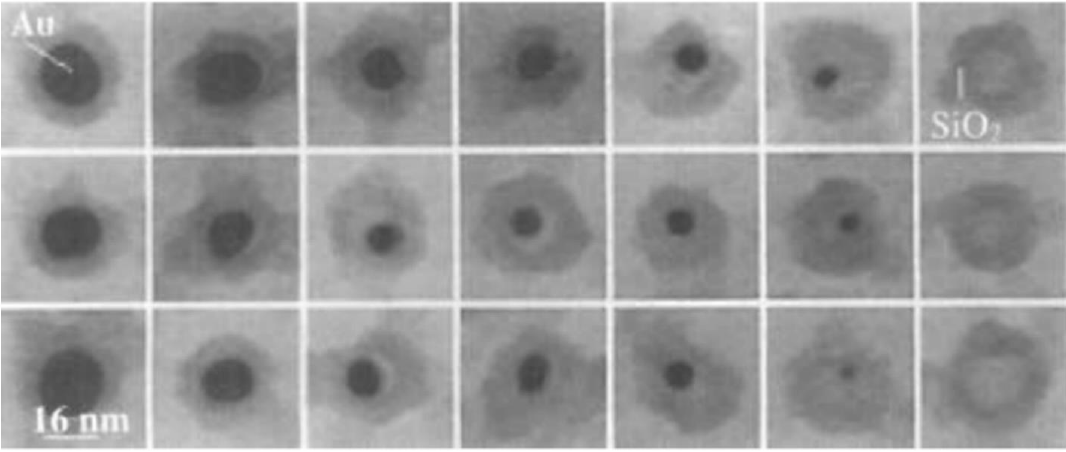
Figure 5. Electron micrographs of three silica-coated gold nanoparticles after adding KCN at 0, 2, 4, 6, 10, and 12 min, respectively. Reprinted with permission from Ref. [93]. Copyright © 1997 Verlag GmbH & Co. KGaA, Weinheim.